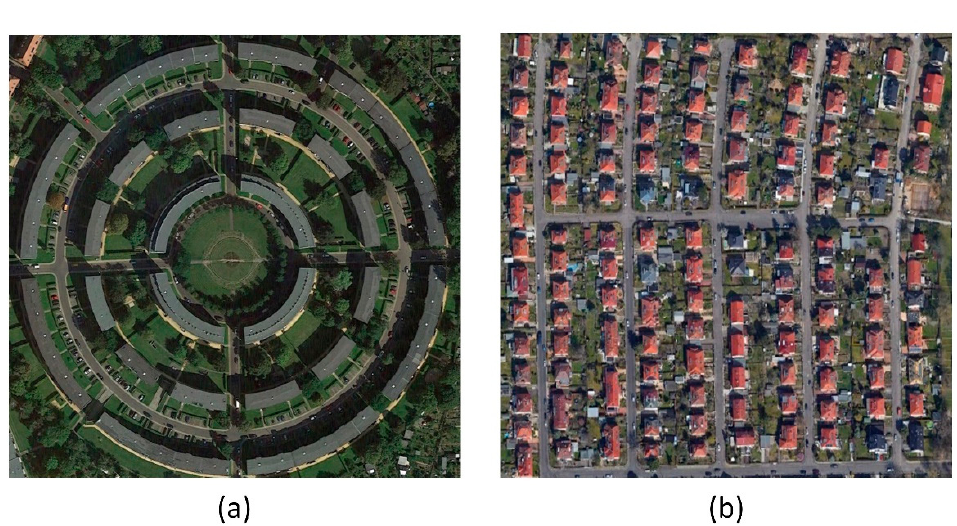
Figure 2. Texture features of different building layouts (image source: Google Earth); ( a ) displays significant isotropy, while ( b ) displays significant